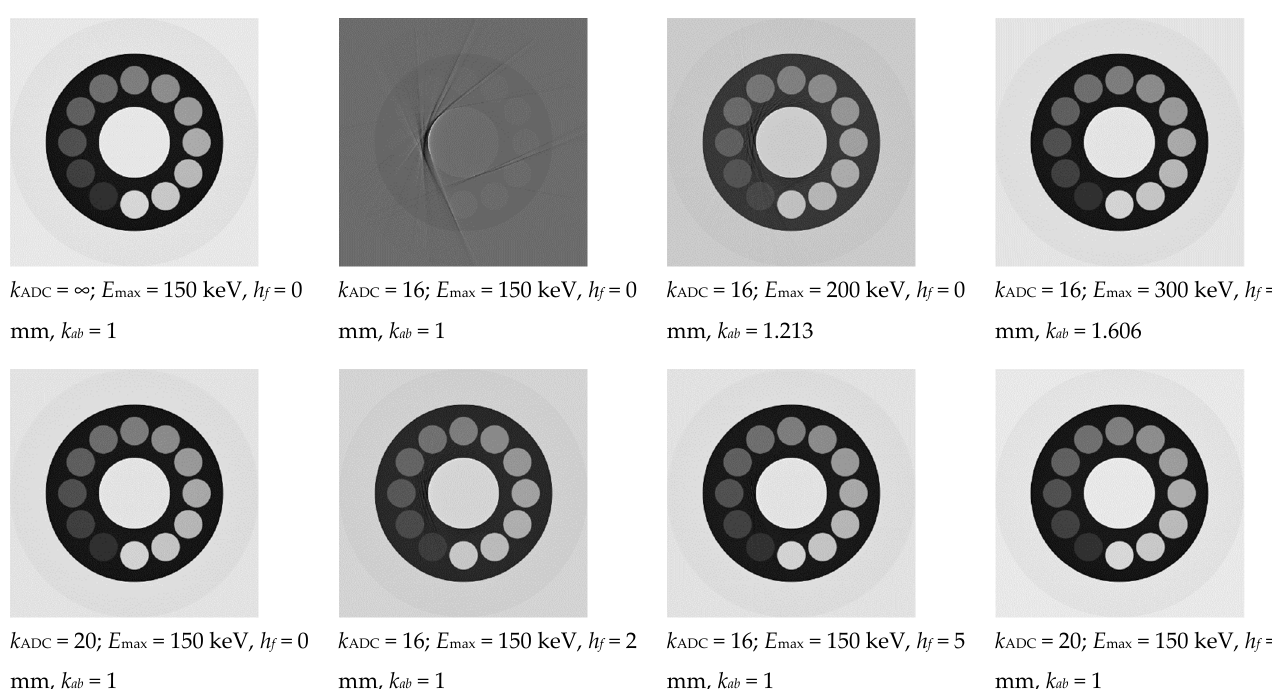
Figure 4. Reconstructed slices of a 250 mm aluminum cylinder with cylindrical inserts.